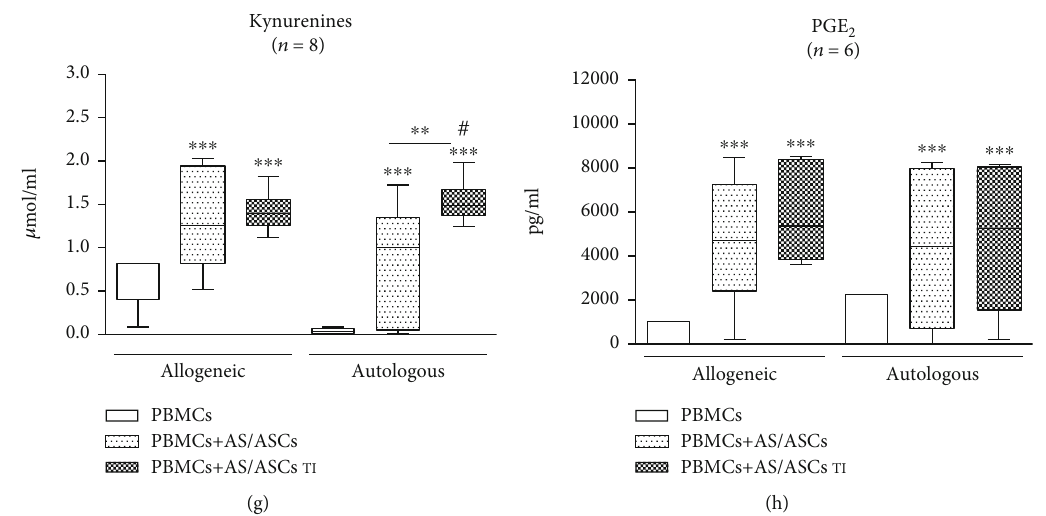
Figure 8: Comparison of immunomodulatory e ff ects of AS/ASCs cocultured with allogeneic and autologous PBMCs. Cells were prepared and cocultured as described in Figure 1. Both allogeneic and autologous PHA-activated PBMCs were used as the target cells. Data are shown as the Tukey ’ s boxes; the number of performed experiments ( n ) is shown. ∗ P = 0 : 05 ‐ 0 : 01 , ∗∗ P = 0 : 01 ‐ 0 : 001 , and ∗∗∗ P = 0 : 001 ‐ 0 : 0001 for comparison of cell cocultures vs. control separate cultures and as indicated. # P = 0 : 05 ‐ 0 : 01 for comparison of allogeneic vs. autologous